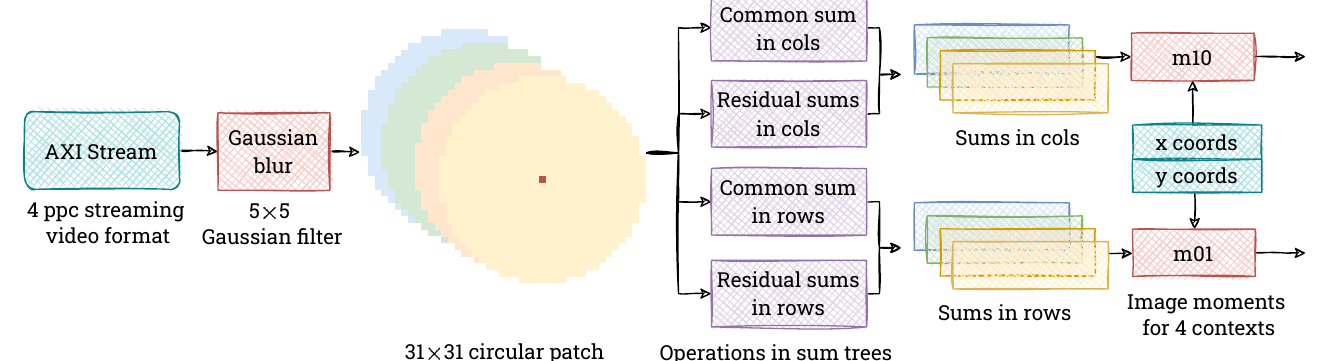
Figure 7. Scheme of the hardware architecture used to calculate the image moments of a patch of the image around a given point. First, we blur the image using the Gaussian filter. Next, we analyse successive image patches, which cover circles (radiuses of 15 px) with centres in four neighbouring points. For each circle, we determine the image moments m 10 and m 01 . For this, we use the sum of the common parts for all circles, thus avoiding performing the same operations repeatedly and saving hardware resources.